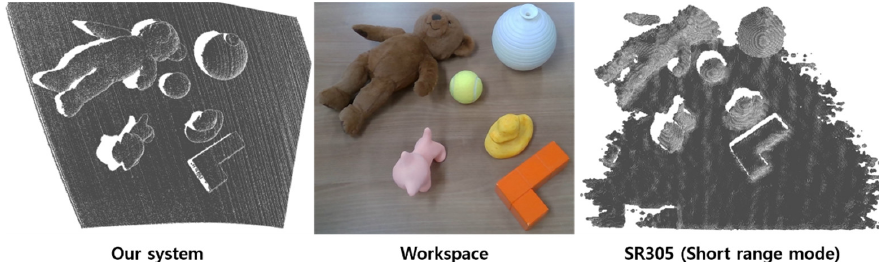
Figure 15. Three dimensional reconstruction of multiple objects with background.